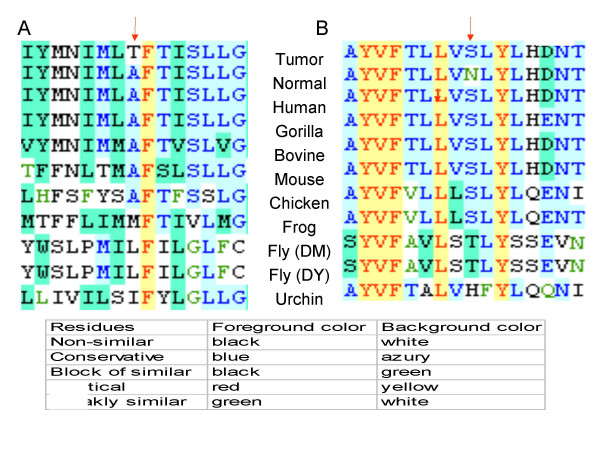
Alignment of novel somatic missense mutations. A: Case E12, G10500A mutation (A11T in ND4L) and B: Case E15, A9182G (N219S in ATPase 6)